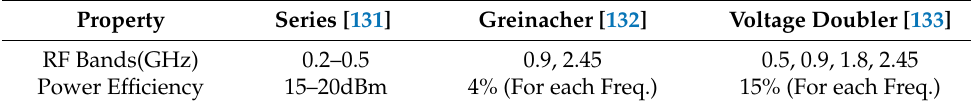
Figure 9. Three topologies: ( a ) series ( b ) voltage doubler and ( c ) Greinacher. Table 2. Comparison between different rectifier